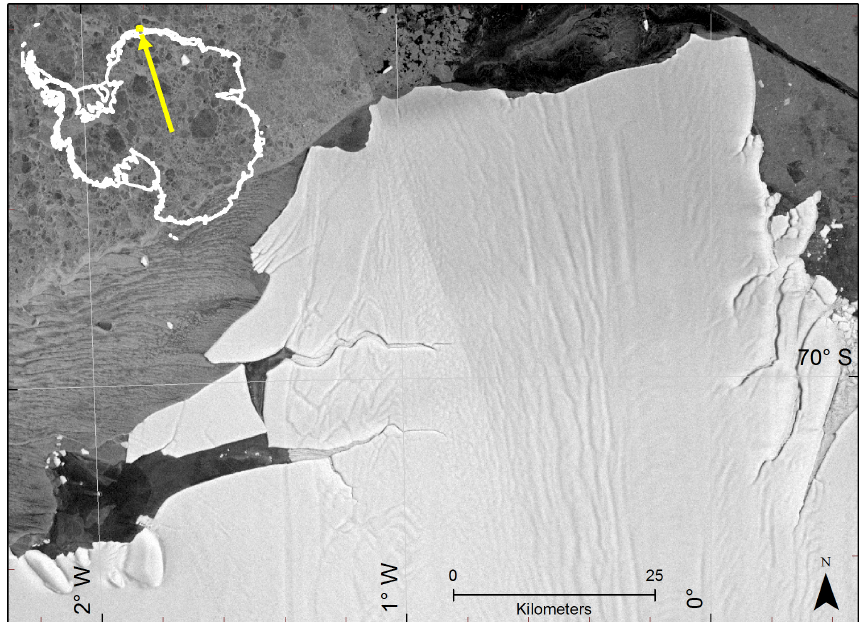
Figure 7. Iceberg calving event at an orthogonal crevassed coastline. The SAR image shows the Trolltunga (Fimbul Ice Shelf). In the upper left the location of this area (yellow rectangle) is indicated. The white lines in the inset image represent the coastline taken from RAMP AMM-1 (http://bprc.osu.edu/rsl/radarsat/data/) and the grounding line taken from Haran et al . [23]. Image courtesy: Byrd Polar Research Center & CSA.